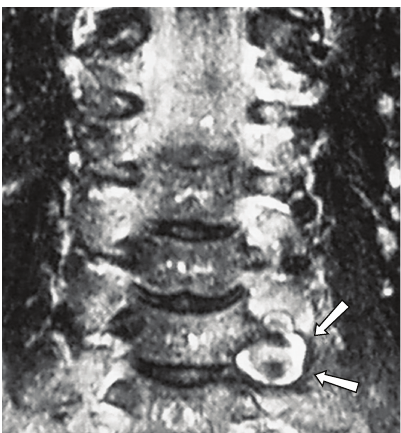
Figure 2: Coronal T2-weighted image of the cervical region; arrows point the aneurysm.